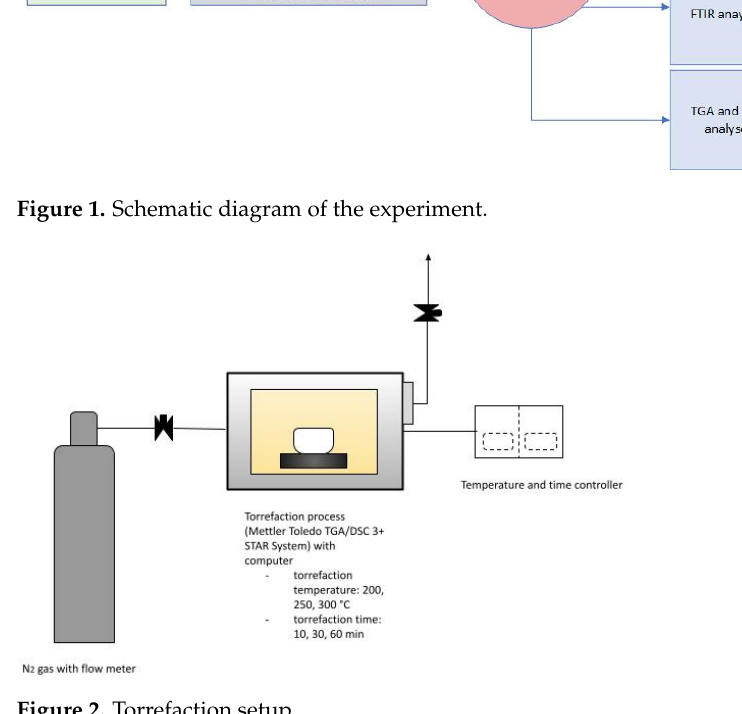
Figure 2. Torrefaction setup.